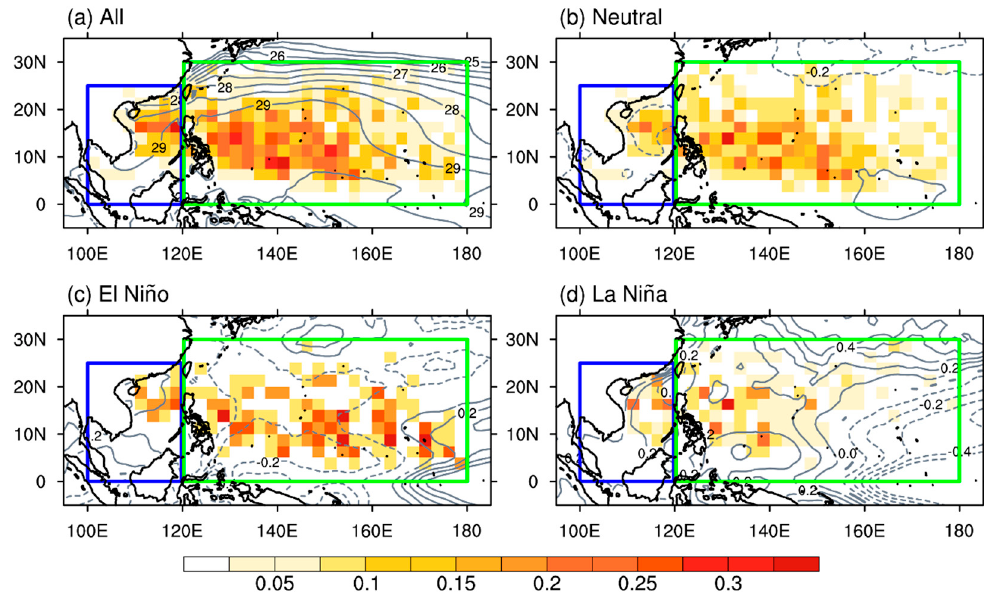
Figure 2. Average frequency of tropical cyclone (TC) genesis (shaded; units: average number per year) and average sea surface temperature (SST) anomaly (contours; interval, 0.05 °C) during June–November season over the period of 1979–2016. ( a ) All years (contours are sea surface temperature (SST)); ( b ) neutral years; ( c ) the El Niño years; ( d ) the La Niña years. Blue box, the South China Sea (SCS) area; green box, the Western North Pacific (WNP) area. Only SST anomalies values that exceeded a 90% confidence level are plotted.